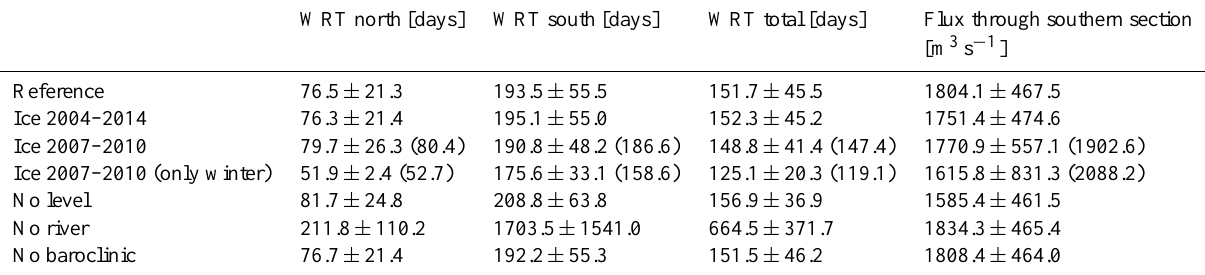
Table 3. Summary of the results of the 10-year simulations. Shown are the renewal times for the northern, southern and the whole basin and the absolute fluxes through the southern section together with their standard deviations. Results are for the complete reference simulation, for the 10-year simulation using ice cover in the 4 years where ice cover was available, only for the 4 years with ice cover and only the winter months with ice cover. The other three rows refer to the simulation with no water level variation in the Baltic Sea, with no river discharge and with no baroclinic forcing. Numbers in brackets are the values for the reference run only for the specified period. WRT north [days] WRT south [days] WRT total